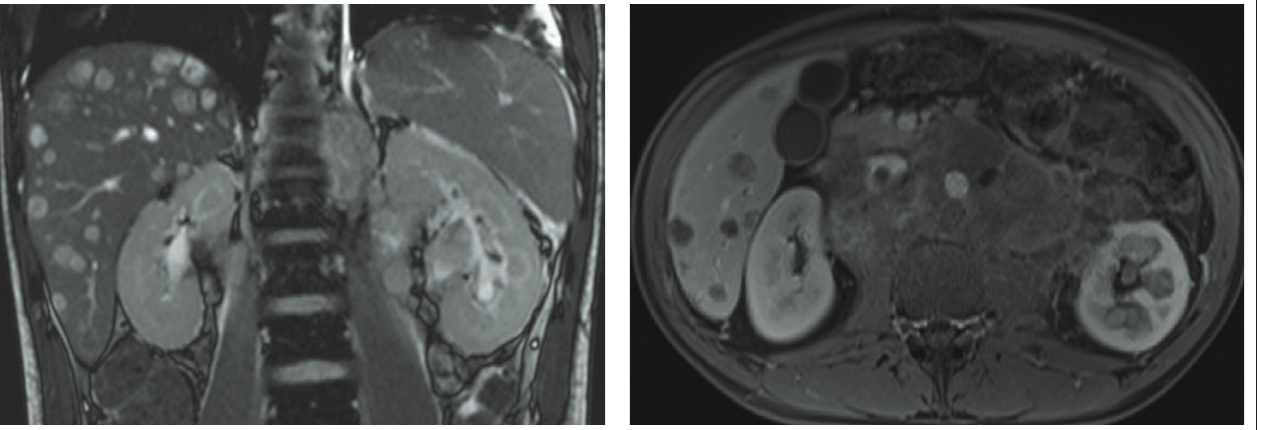
Fig. 13. Axial post-Primovist T1-weighted MR image at the level of segment 6 of the